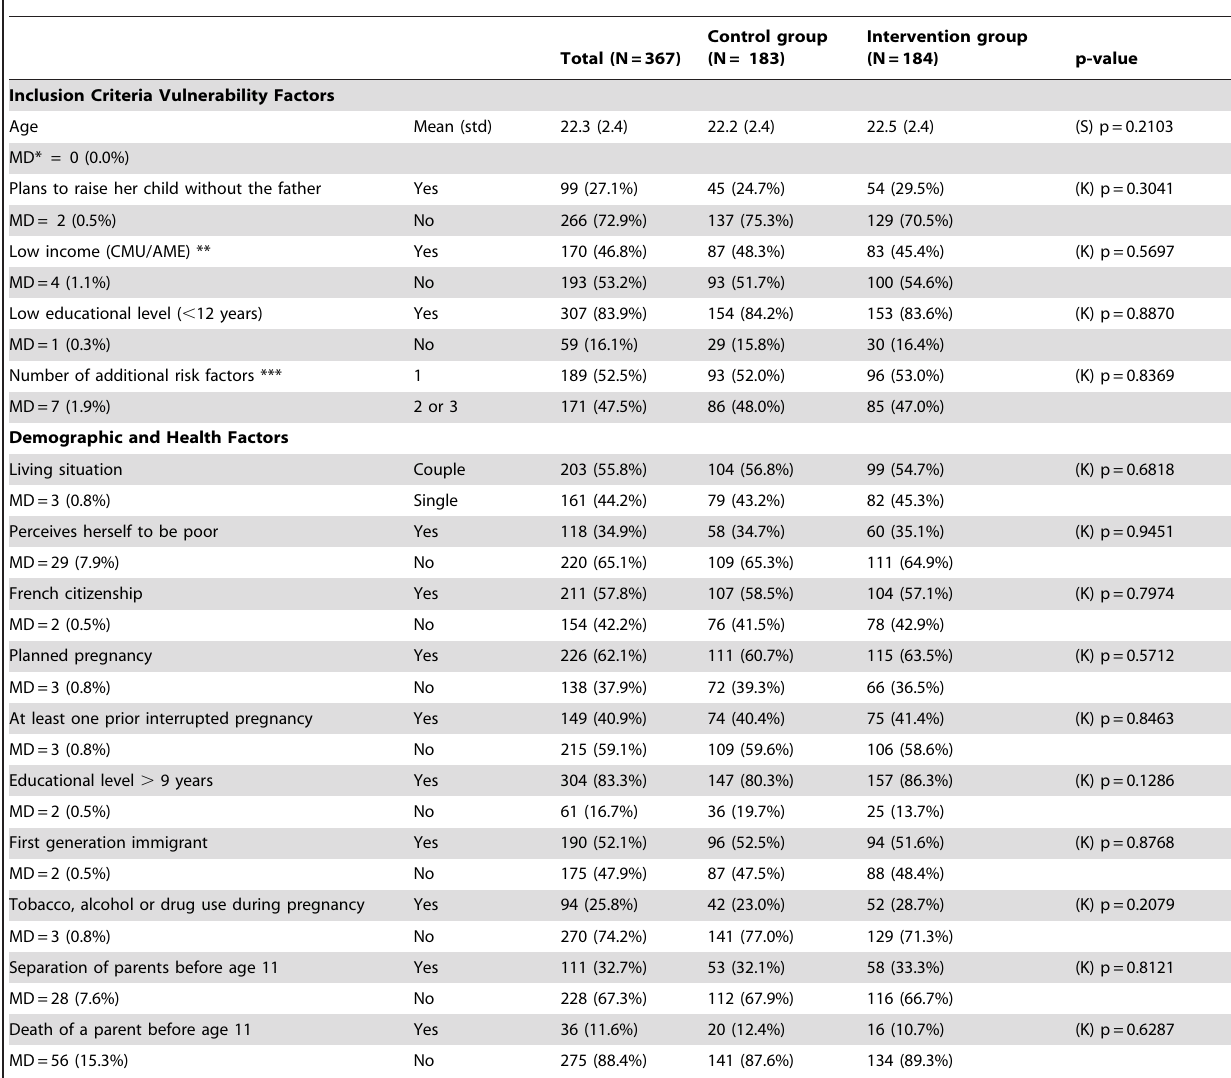
Table 1 . Demographic and health characteristics of the study population (N =367).